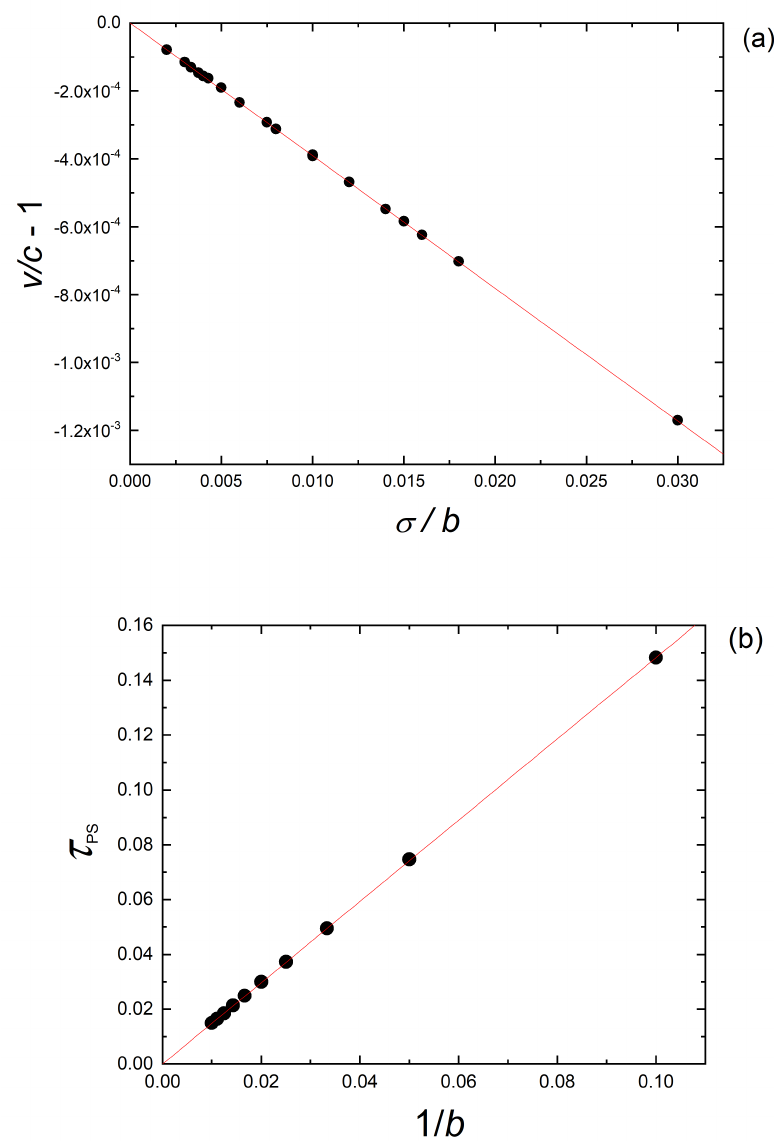
Figure 6. ( a ) Plot of the phase soliton velocity as a function of σ / b . ( b ) Plot of the temporal width of the phase soliton scaled to the roundtrip time as a function of 1/ b . Both plots admit a linear fit, shown as a red